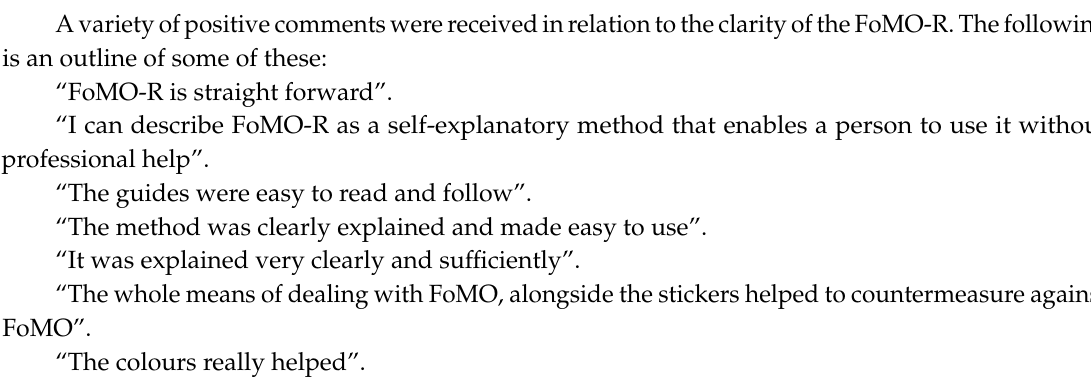
Figure 5. Coherence of FoMO-R.